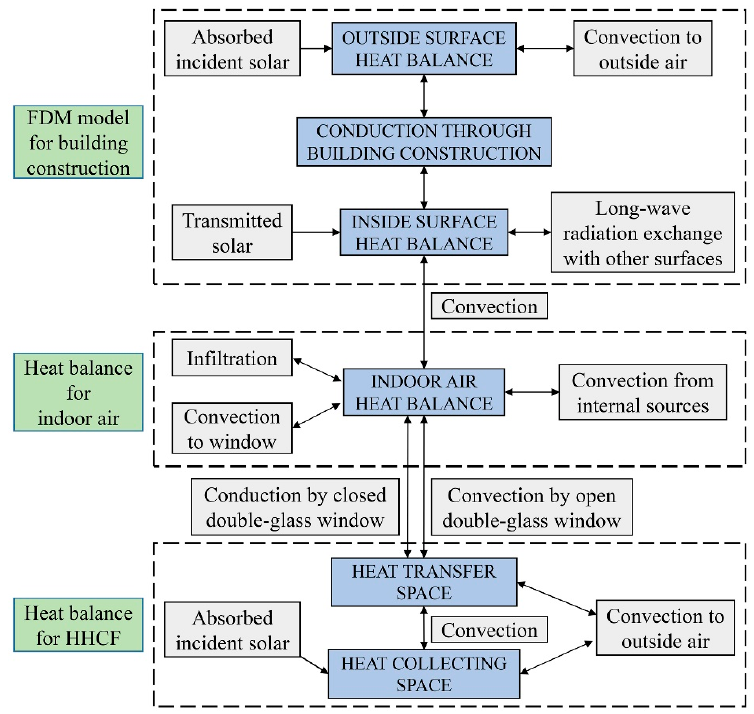
Figure 4. Heat balance solution procedure for the building with the HHCF.